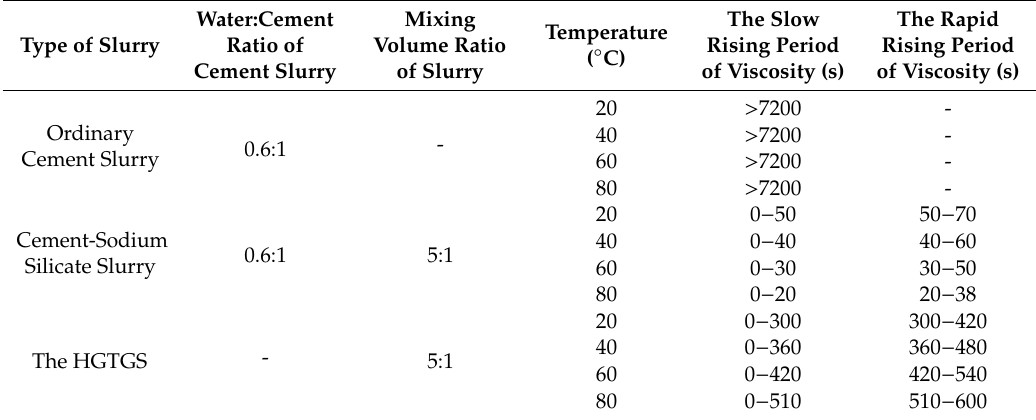
Table 5. The parameters of viscosity periods of three di ff erent slurries in specific temperature conditions.